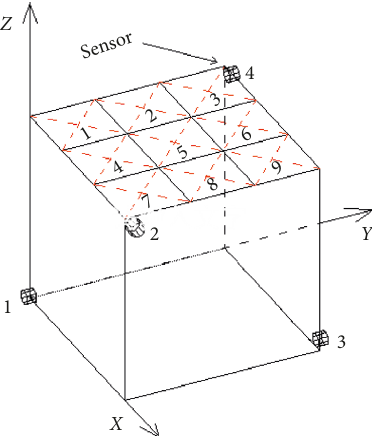
Figure 7: Schematic diagram of the sensor layout.